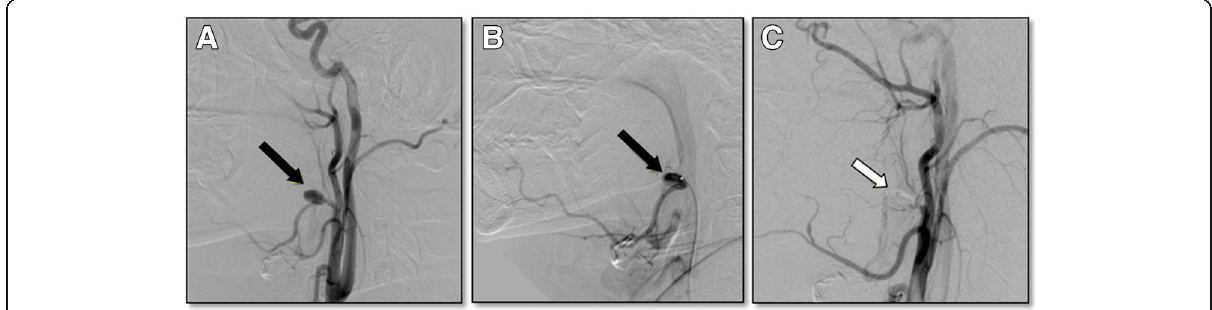
Fig.1 a ECA angiography shows a pseudoaneurysm (black arrow) arising at the primal part of the facial artery. b S uperselective angiogram with the tip of microcatheter within the pseudoaneurysm (black arrow). c Post embolization ECA angiography, showing total occlusion of the pseudoaneurysm (white